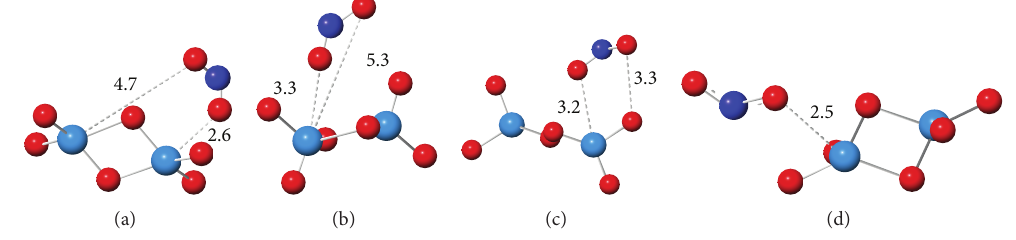
Figure 5: Different models of NO 2 adsorption on W 2 O 6 .